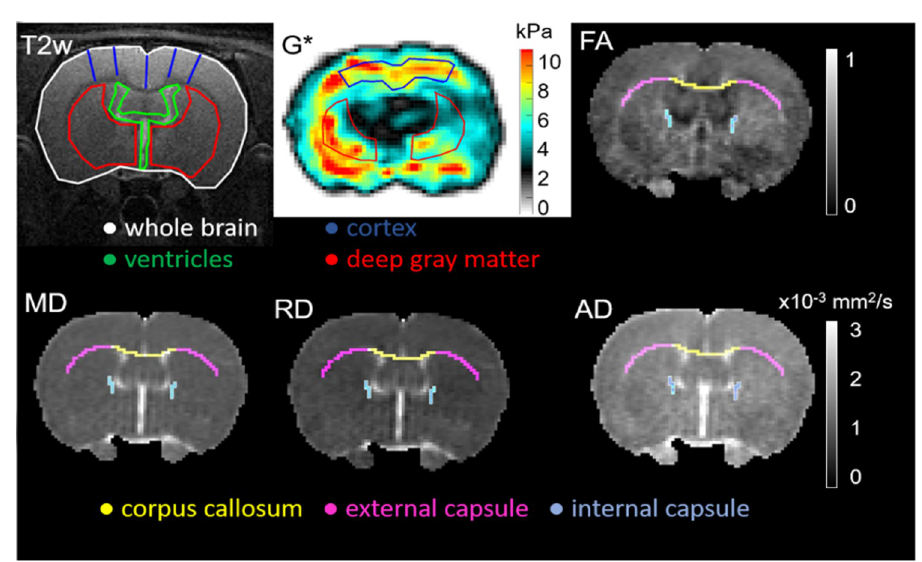
Fig 1. Typical images/maps obtained with this MRI protocol. Anatomical T2 weighted (T2W) image; shear modulus (G � ) map, as measured by MRE at 800 Hz; fractional anisotropy (FA), mean diffusivity (MD), axial and radial diffusivity (AD and RD) maps, as measured with DTI (Bregma -0.72 mm (29)). Anatomical images were used to measure the cross-sectional areas of the ventricular system (green), whole-brain (white), and deep gray matter (red), along with the cortical thickness in the middle slice acquired (navy blue). The cortical thickness was averaged over 5 locations on the “roof” of the lateral ventricles. The magnitude of the complex shear modulus (G � ) was calculated for the cortex (navy blue) and deep gray matter (red). FA, MD, RD and AD were obtained for the corpus callosum (yellow), external (pink) and internal (purple) capsules. 31 contiguous slices of 1 mm thickness, FOV = 25.6 × 25.6 mm, in-plane resolution = 200 × 200 μ m, acquisition time = 3 min 3s.